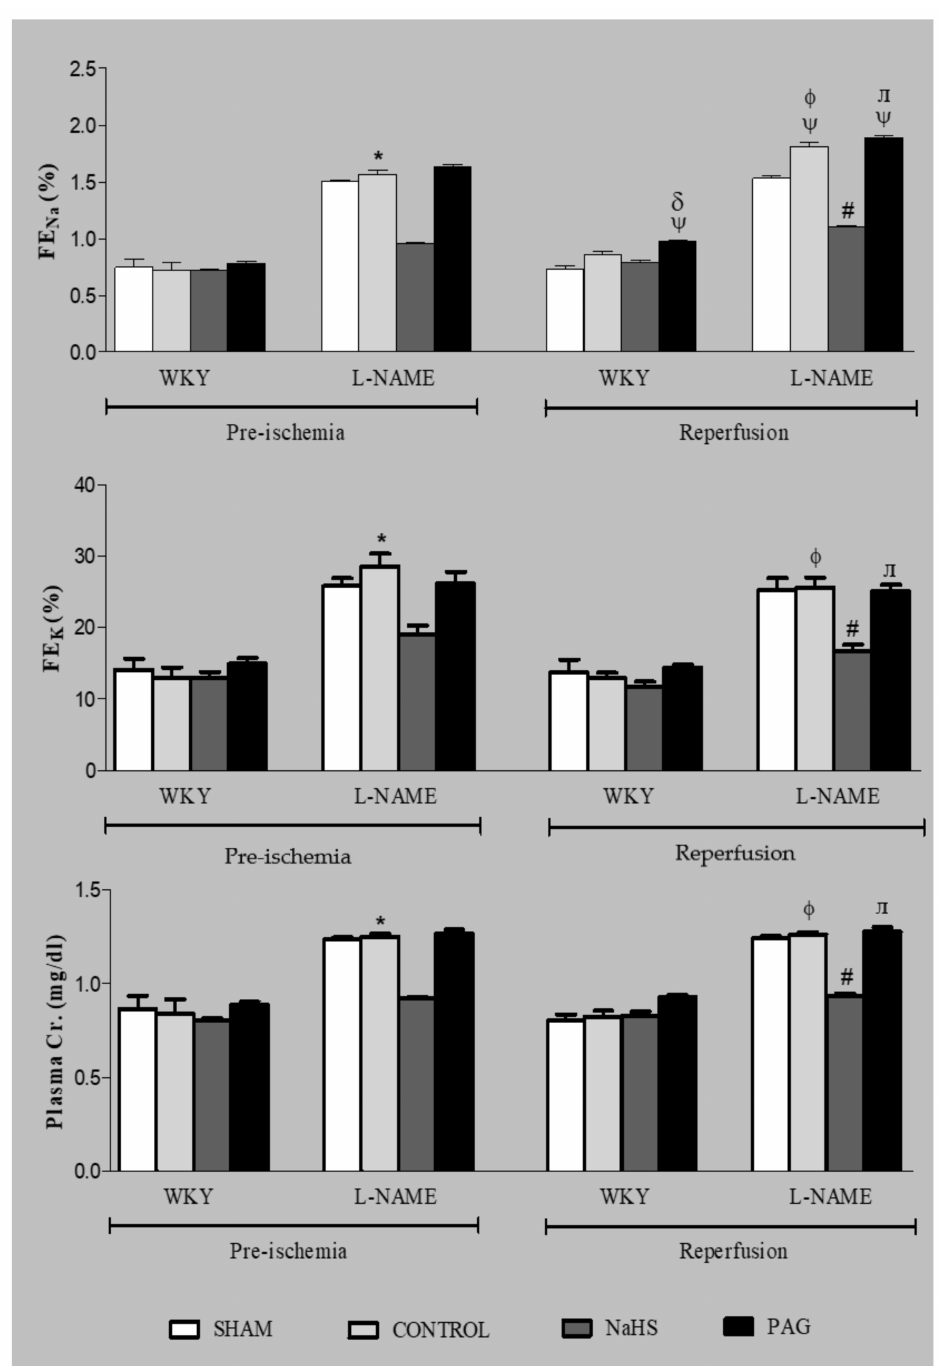
Figure 3. FE Na , FE K and plasma creatinine measurements for different experimental groups of WKY and L-NAME rats before and after ischemia ( n = 6). Data were analysed using one-way ANOVA followed by Bonferroni’s post hoc test. Ψ p < 0.05 vs. pre-ischemic phase of respective groups; * p < 0.05 vs. WKY-CONTROL at pre-ischemic phase; φ p < 0.05 vs. WKY-CONTROL at reperfusion phase; δ p < 0.05 vs. WKY+NaHS at reperfusion phase; # p < 0.05 vs. L-NAME- CONTROL at reperfusion phase; л p < 0.05 vs. L-NAME+NaHS at reperfusion phase. FE Na = fractional excretion of sodium, FE K = fractional excretion of potassium, Cr. = creatinine, PAG = dL-propargylglycine, WKY = Wistar Kyoto rats, L-NAME =